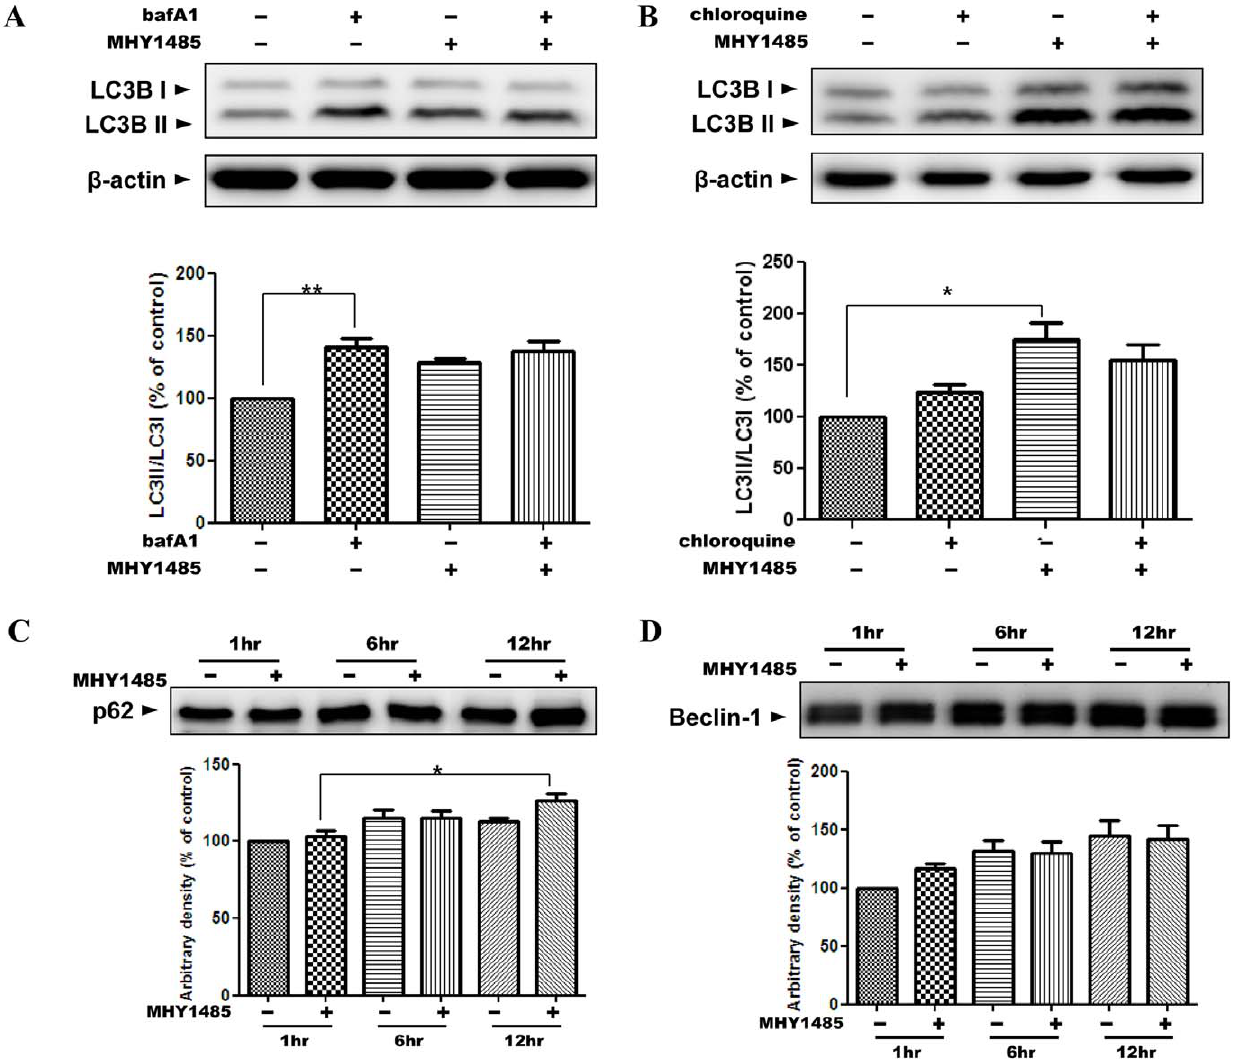
Figure 3. Failure of the increase of autophagic flux. Western blot analysis was performed with samples from cells treated in 2 m M MHY1485 for 6 h. The lysosomotropic agents bafilomycin A1 (bafA1, 10 nM) and chloroquine (100 m M) were applied 1 h before the cell harvest to measure the autophagic flux (A, B). Bars represent the LC3II/LC3I ratio normalized with the LC3II/LC3I ratio from untreated samples. b -Actin blot is shown to verify the same amount of protein loaded. The blots were quantified by densitometry expressed as mean 6 SD (**p , 0.01; n=3). C and D show the immunoblots of p62 and beclin-1 in samples from the cells treated with MHY1485 or the same amount of vehicle for different times. The blots were quantified by densitometry and were normalized with the control sample at 1 h expressed as mean 6 SD (*p , 0.05; n=3).